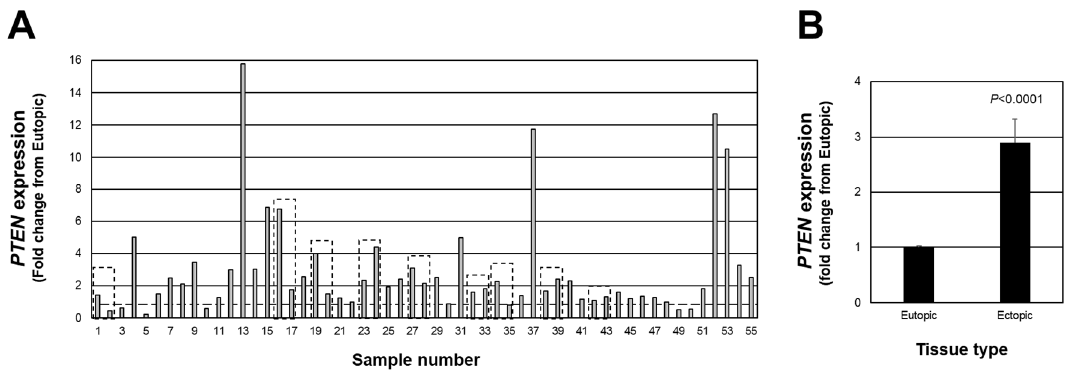
Figure 1. Fold change in PTEN expression in peritoneal endometriotic lesions. Data are expressed as the fold change from eutopic endometrial levels for each lesion ( A ) as well as the overall average fold change ( B ). Broken line in ( A ) depicts a fold ‐ change of 1.0 which is equal to the expression in eutopic endometrial tissue. Boxed areas indicate lesions obtained from the same patient at the time of surgery.